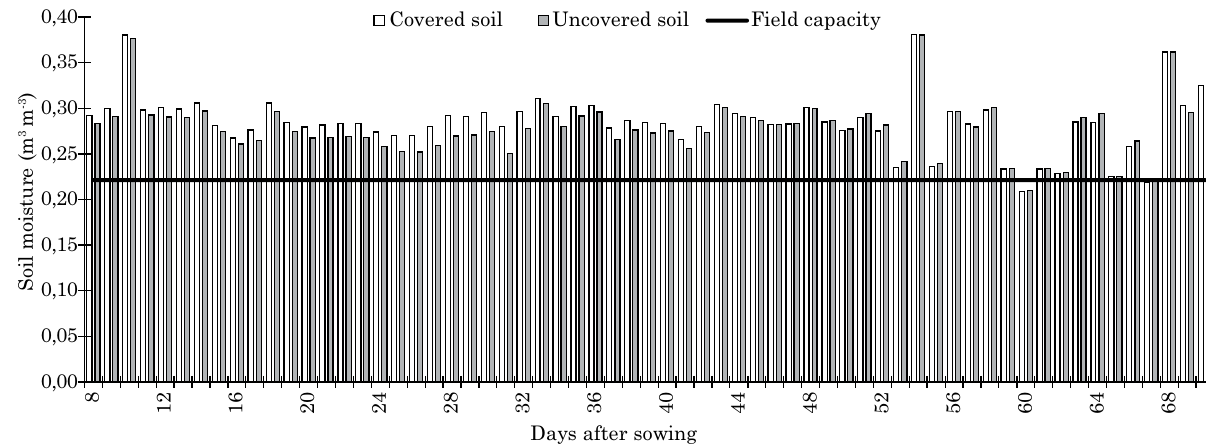
Figure 5. soil water content throughout the experiment.